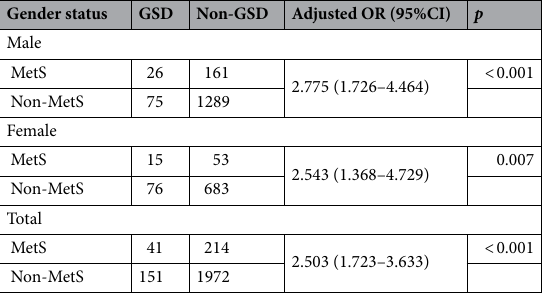
Table 4. Age-adjusted association of MetS with GSD by sex. GSD Gallstone disease, MetS Metabolic syndrome, OR Odds ratio, CI Confidence interval.